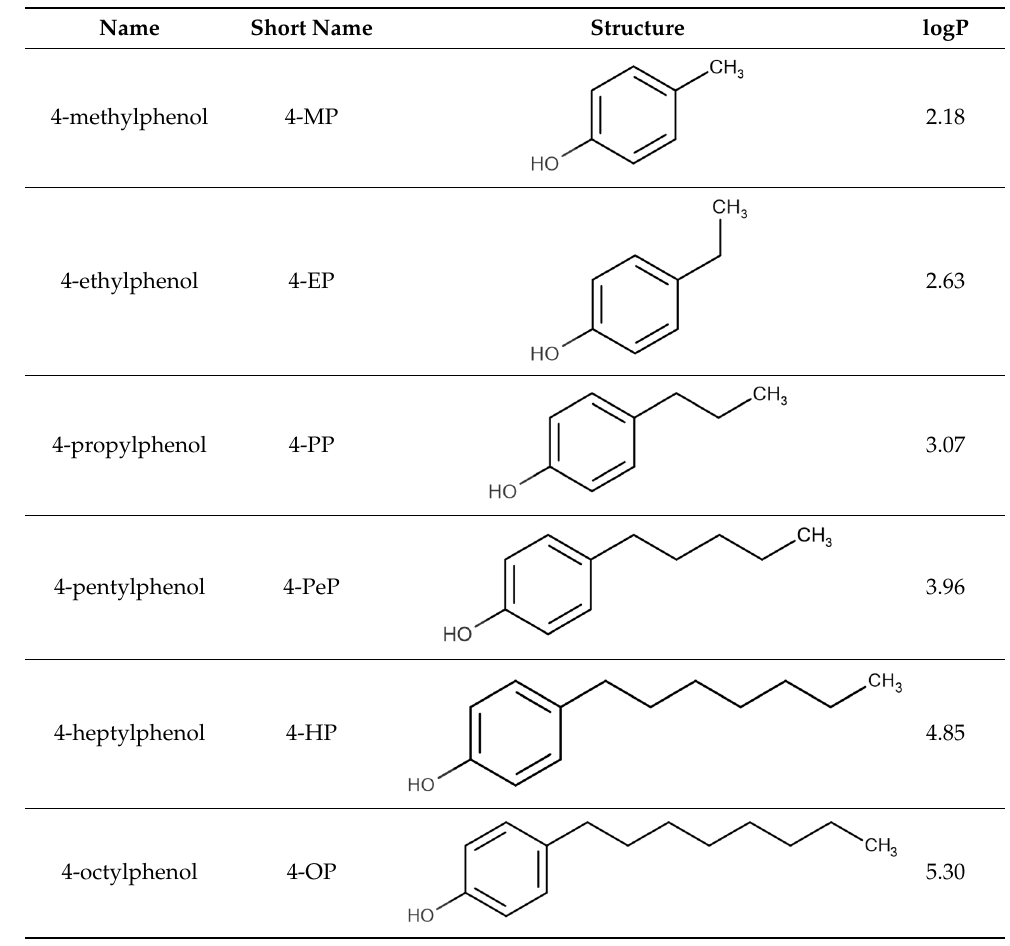
Table 1. List of reagents used in the study, structure, partition coefficient (logP). The purity is above 97% for all compounds.